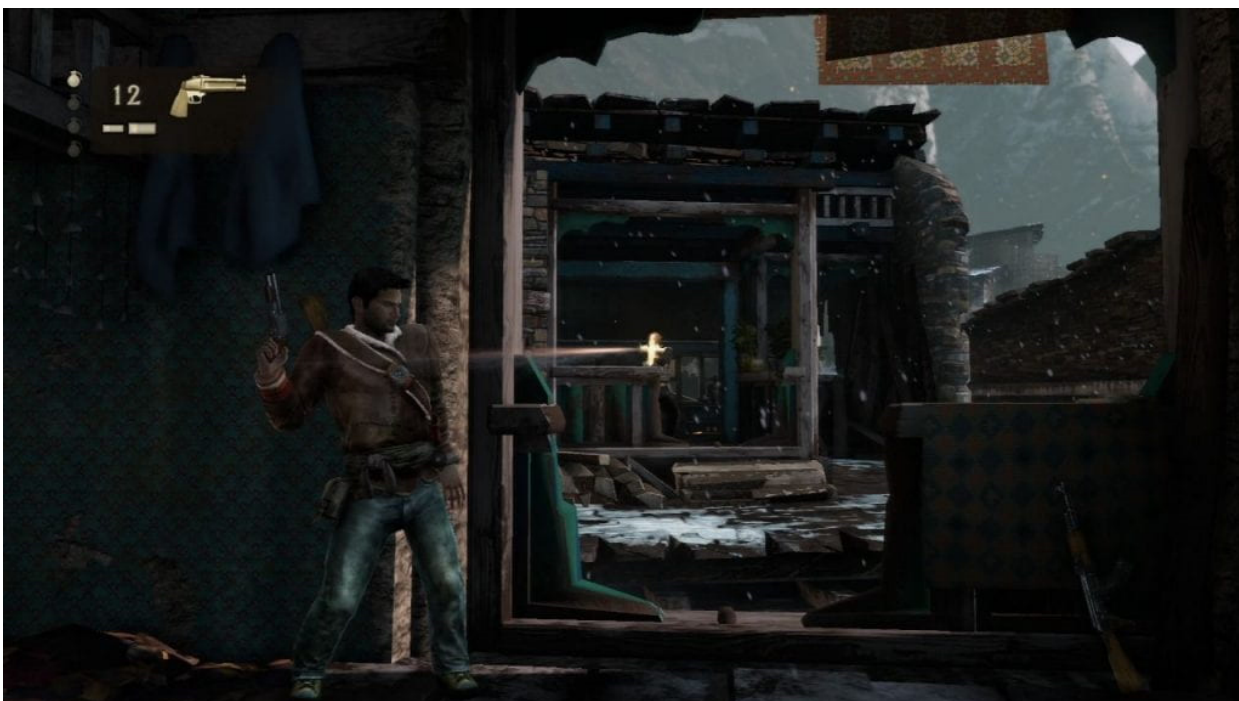
Figure 12. In third-person videogames like Uncharted 2 , the player must look back and forth between the diegetic and non- diegetic frame. (Screenshot created by author).